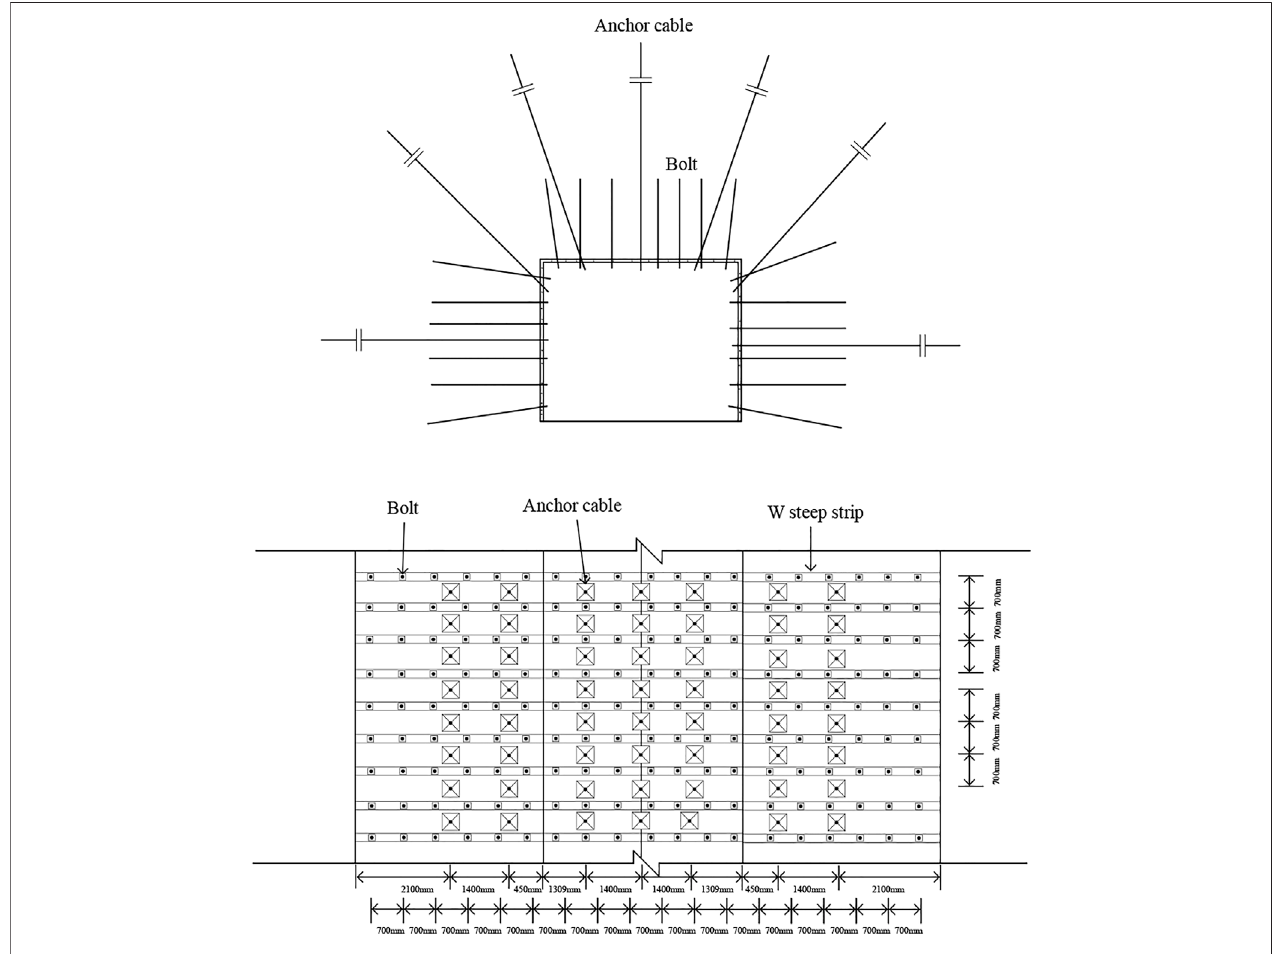
FIGURE 7 | Schematic diagram of cross-sectional